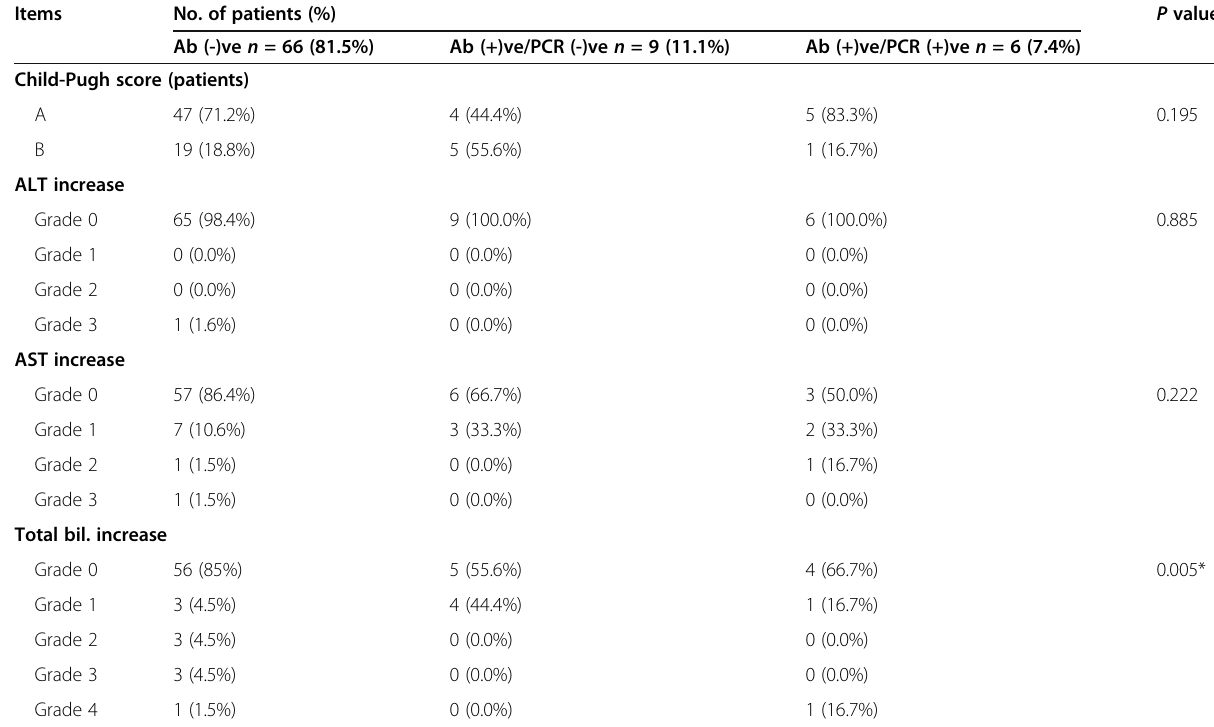
Table 2 Hepatic adverse effects among 81MM